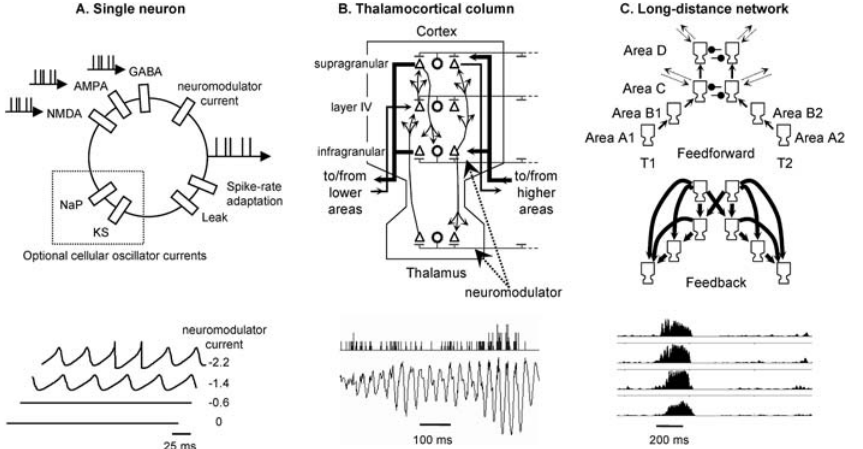
Figure 1. Simulation Components and Resulting Spontaneous Activity Shown are the constituents of the simulation (upper diagrams) and typical patterns of spontaneous activity that they can produce (lower tracings). We simulated a nested architecture in which spiking neurons (A) are incorporated within thalamocortical columns (B), which are themselves interconnected hierarchically by local and long-distance cortical connections (C) (see Materials and Methods for details). While single neurons may generate sustained oscillations of membrane potentials (A), only the column and network levels generate complex waxing-and- waning EEG-like oscillations (B) and metastable global states of sustained firing (C). DOI: